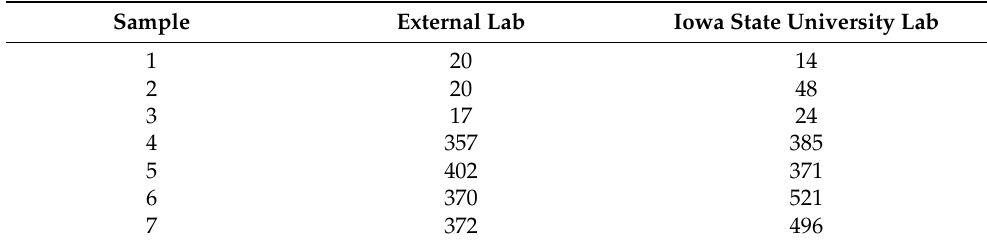
Table 7. Inter-laboratory reproducibility results